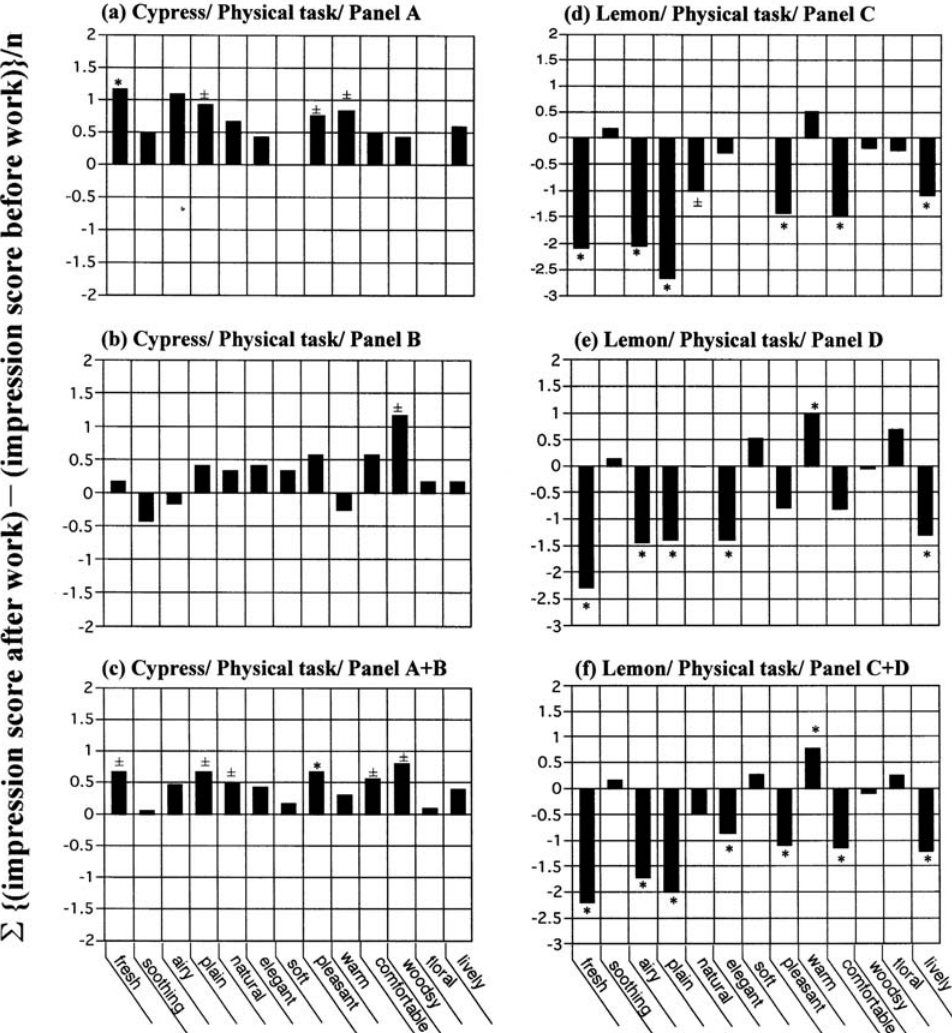
Figure 3. A duplication of sensory profiling conducted for cypress and lemon each versus physical task. In each column, a duplication of sensory profiling was conducted using two sets of mutually different panels, where no participant overlapped as panelist. The number of subjects was ( a ) 12 for Panel A, ( b ) 12 for Panel B and ( c ) 24 for Panel A+B as with cypress versus physical task; ( d ) 21 for Panel C, ( e ) 23 for Panel D and ( f ) 44 for Panel C+D as with lemon versus physical task. The total significance scores were 2.5 for ( a ), 0.5 for ( b ), 3.5 for ( c ), 6.5 for ( d ), 6.0 for ( e ) and 8.0 for ( f